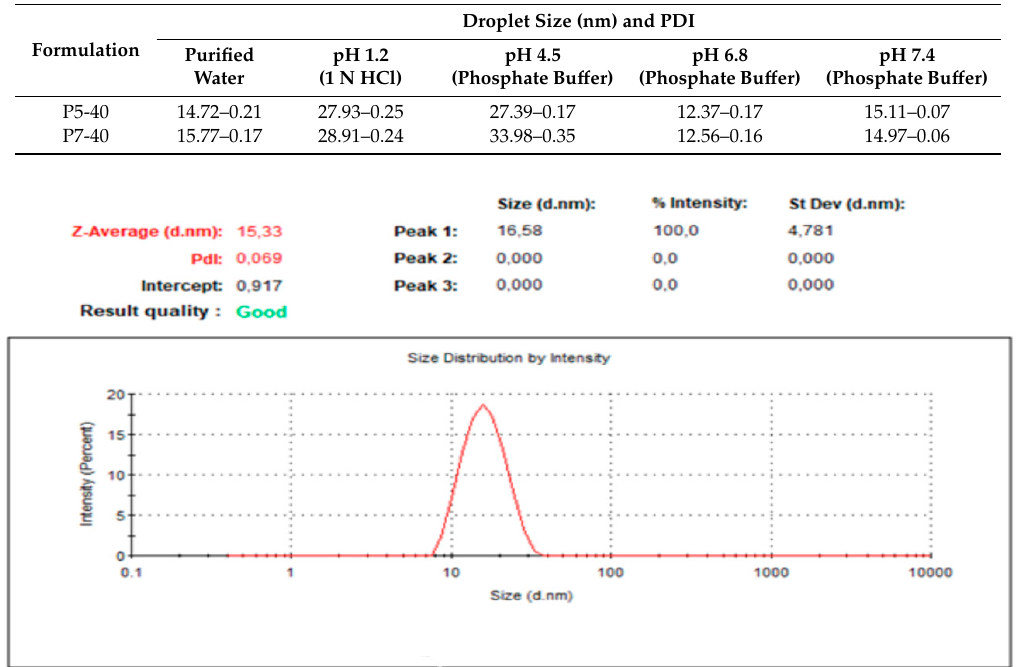
Table 4. E ff ect of pH of the dispersion media on droplet size (nm) and PDI ( n = 3).